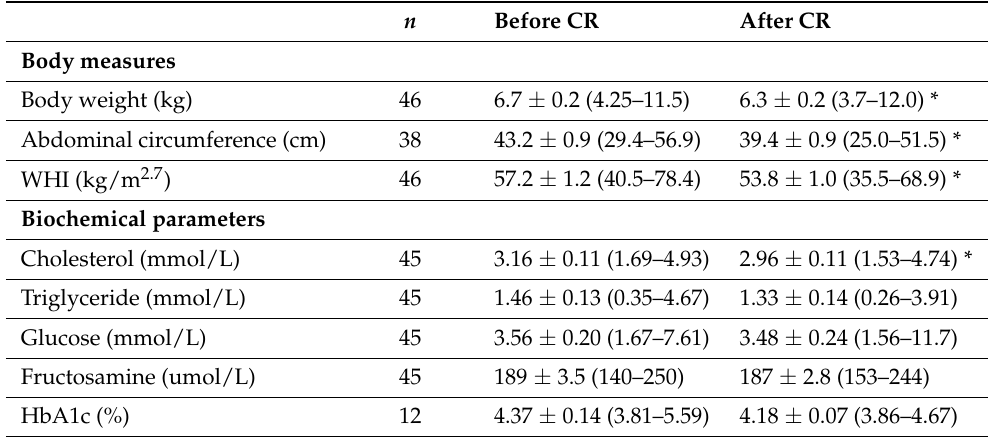
Table 2. Mean ± SE (minimum–maximum) body measures and biochemical parameters of full-grown adult long-tailed macaques before and after mild caloric restriction (CR) started. * p < 0.05. n Before CR After CR Body